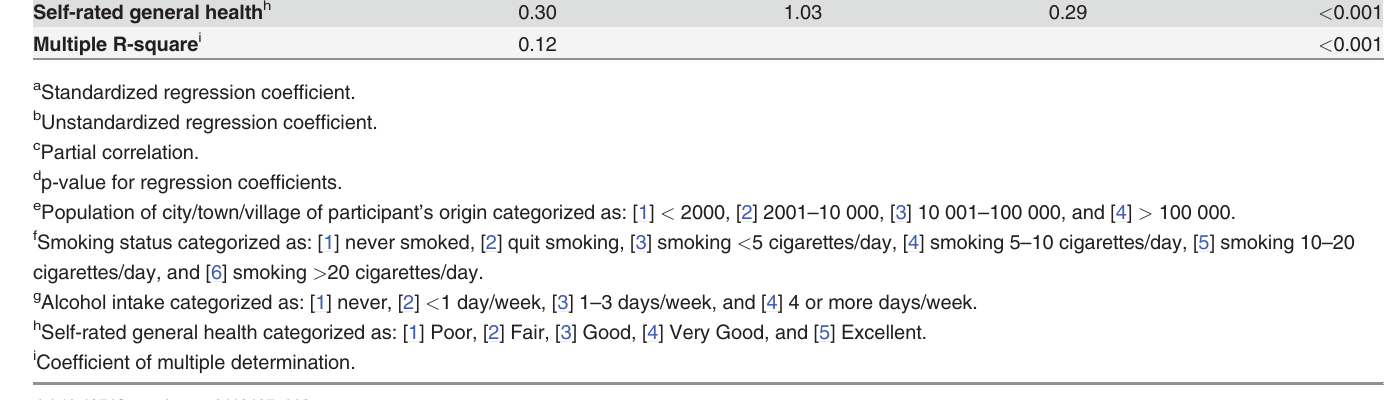
a Standardized regression coef fi cient.